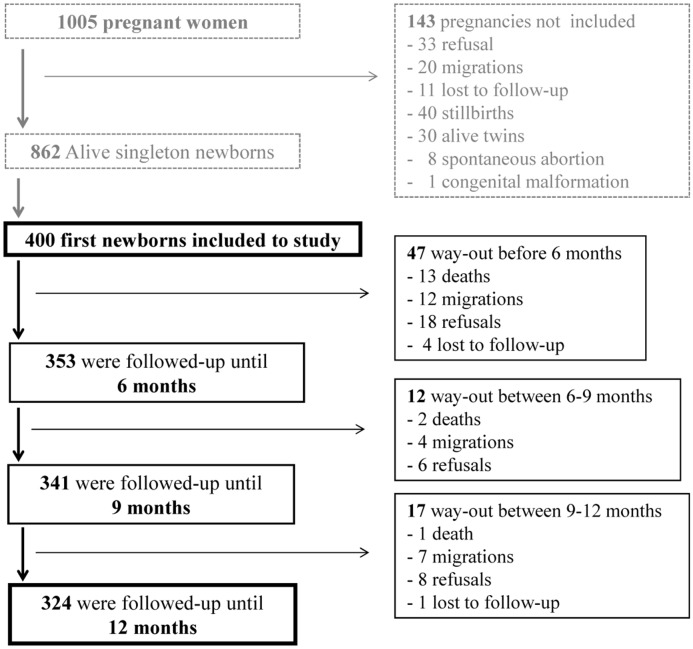
Flowchart diagram of follow-up.Infants who were absent more than 3 consecutive months, and not seen before their 12 months were considered as lost to follow-up. During the study, five infants (0.1%) were lost to follow-up and sixteen (0.4%) died. The main reasons of death were: acute respiratory infection (4), neonatal icterus (1), severe malaria (2), unknown disease (7), congenital biliary atresia (1). Among these deaths, only 1.2% (2/16) of infants have been bring to hospital by parents.